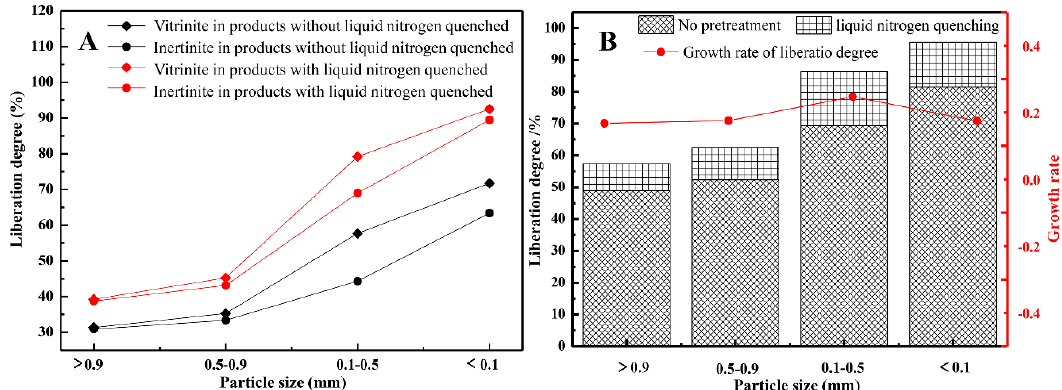
Figure 7. Particle sizes and liberation degree. ( A ) Liberation degree of single maceral; and ( B ) liberation degree of macerals in